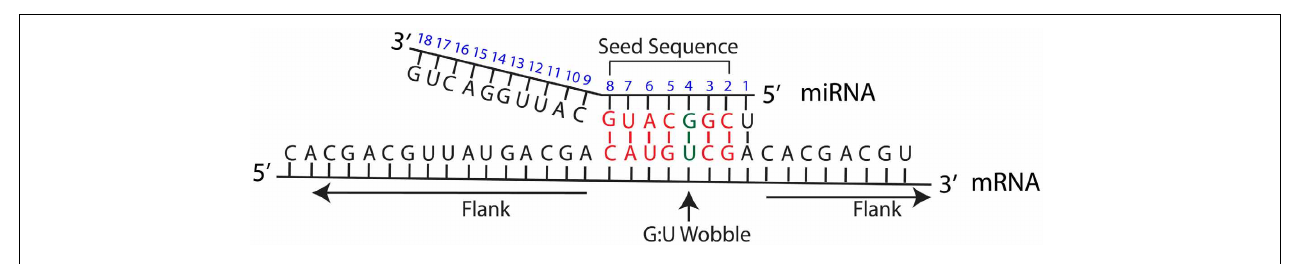
FIGURE 1 | miRNA:mRNA target interaction. Schematic overview of a miRNA interaction with its mRNA target. MiRNA position number is shown in blue. The seed sequence refers to nucleotides in miRNA position number 2–8. Flank refers to the mRNA sequence